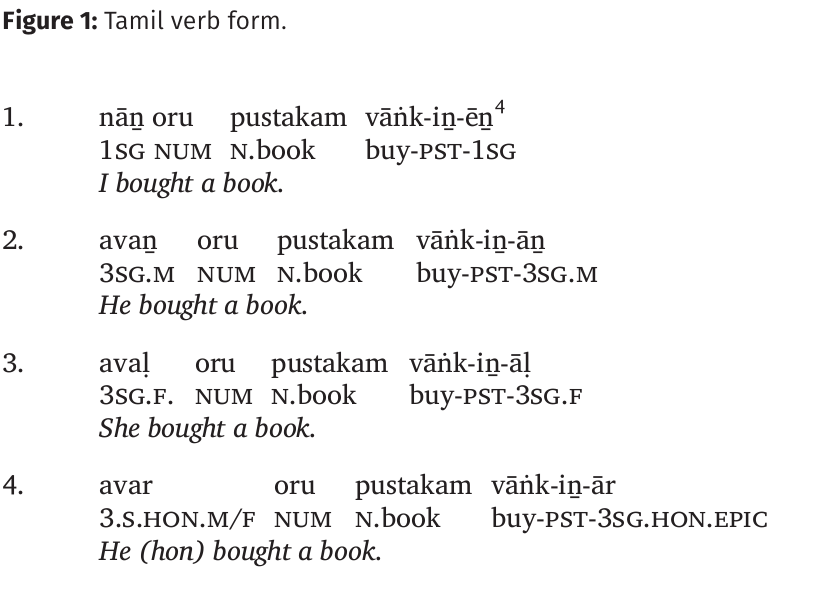
Figure 1: Tamil verb form.